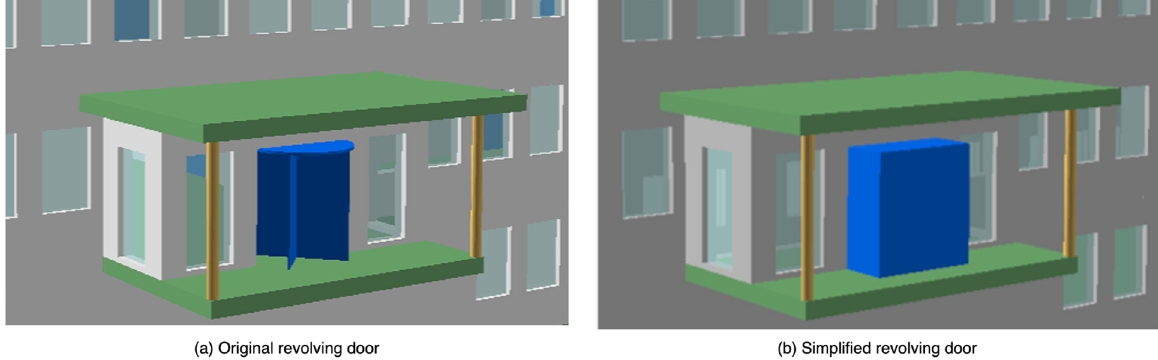
Figure 19. Simplification of the entrance door of the institute building model. ( a ) Original revolving door. ( b ) Simplified revolving